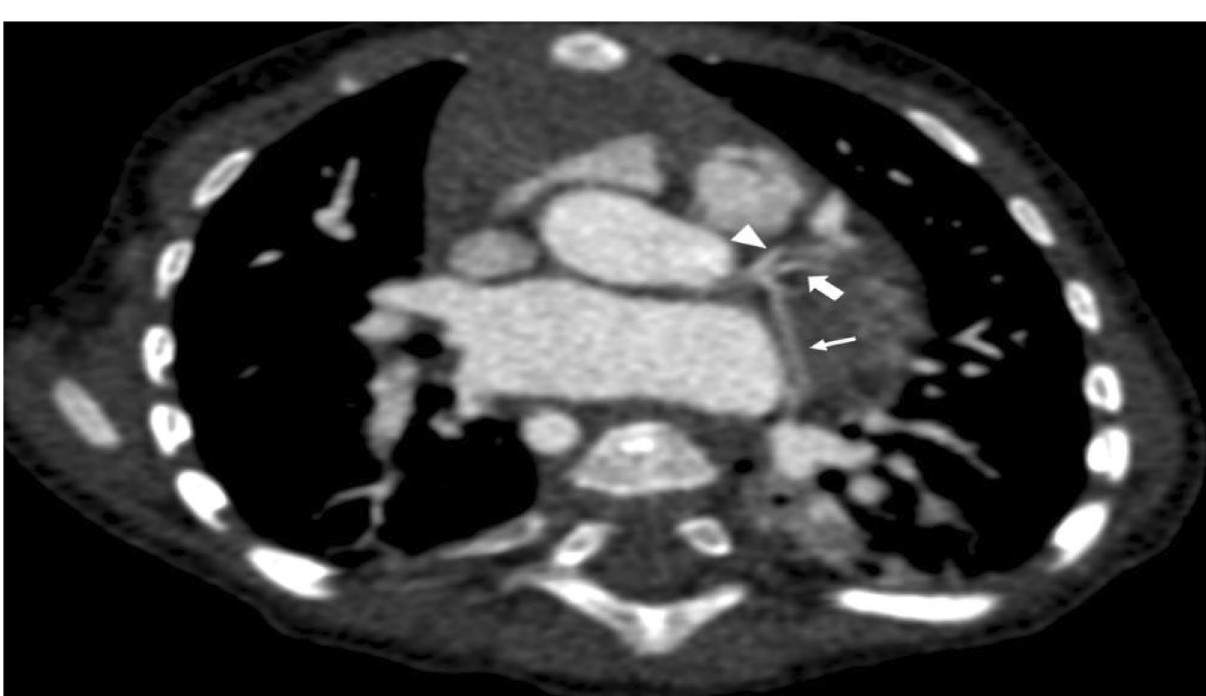
Figure 3. Double angulated reconstruction demonstrating a trifurcation of the left main coronary artery giving rise to the left anterior descending artery (arrowhead), a left median branch (thick arrow), and the left circumflex artery (thin arrow) in a 5-month-old female infant with a tetralogy of